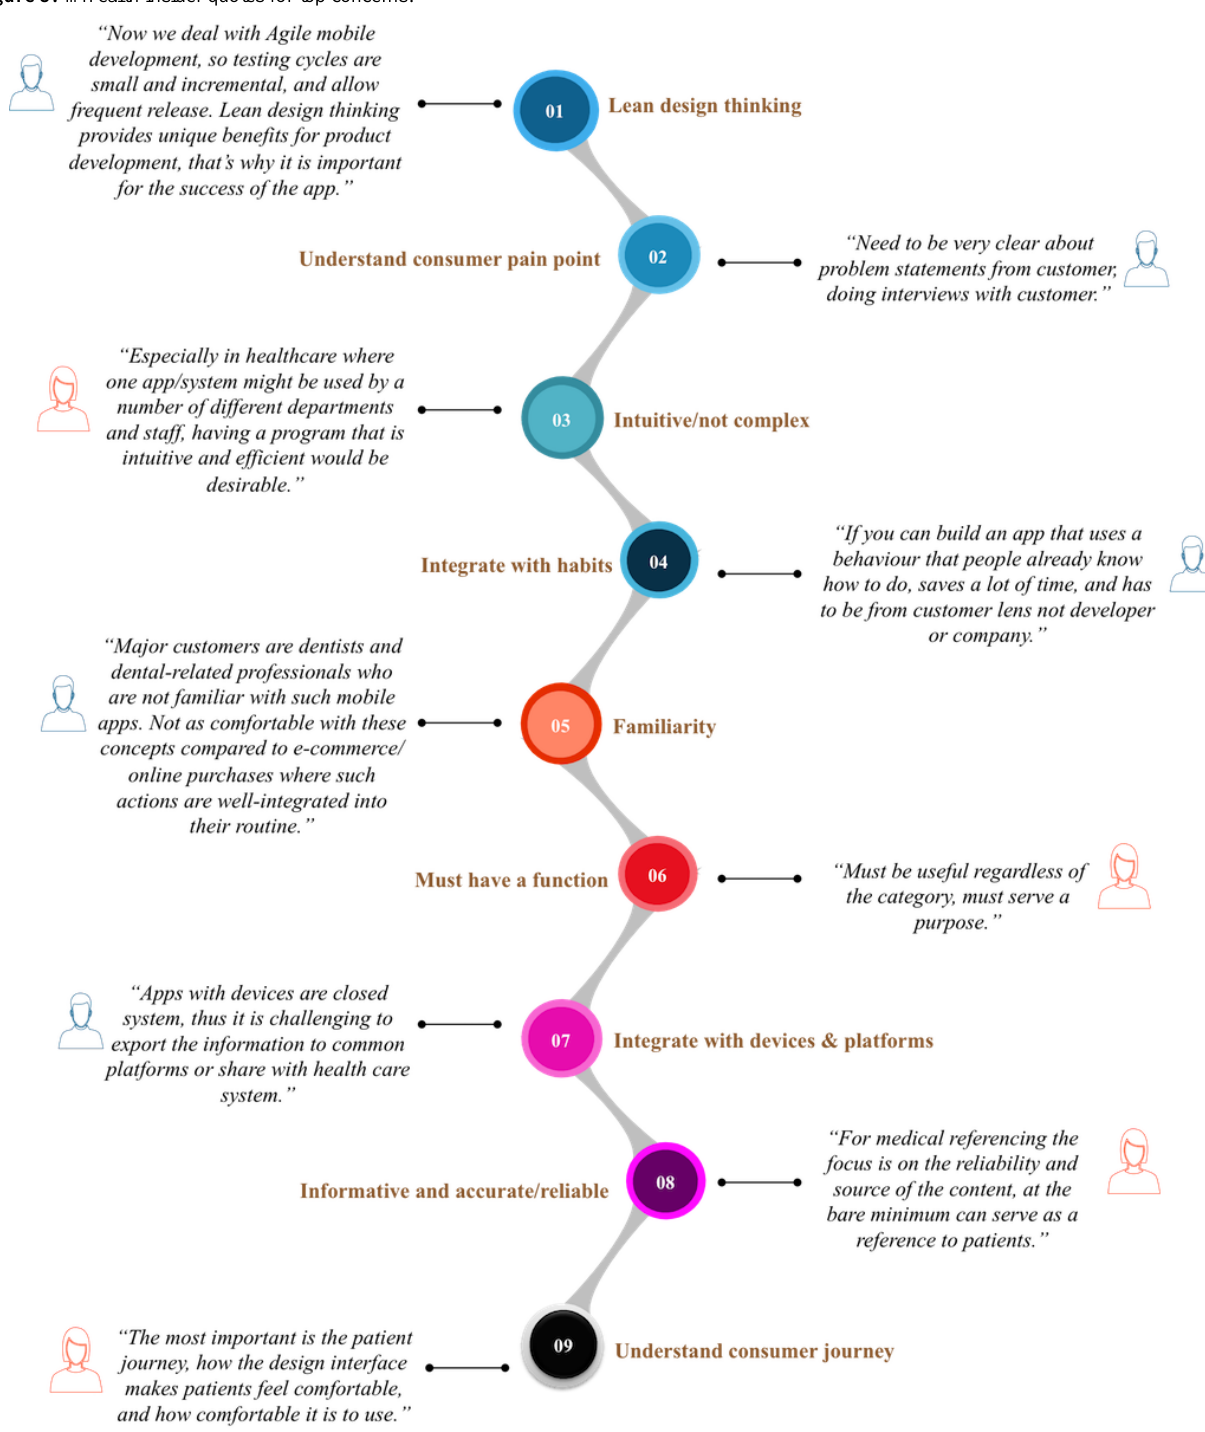
Figure 8. mHealth insider quotes for top